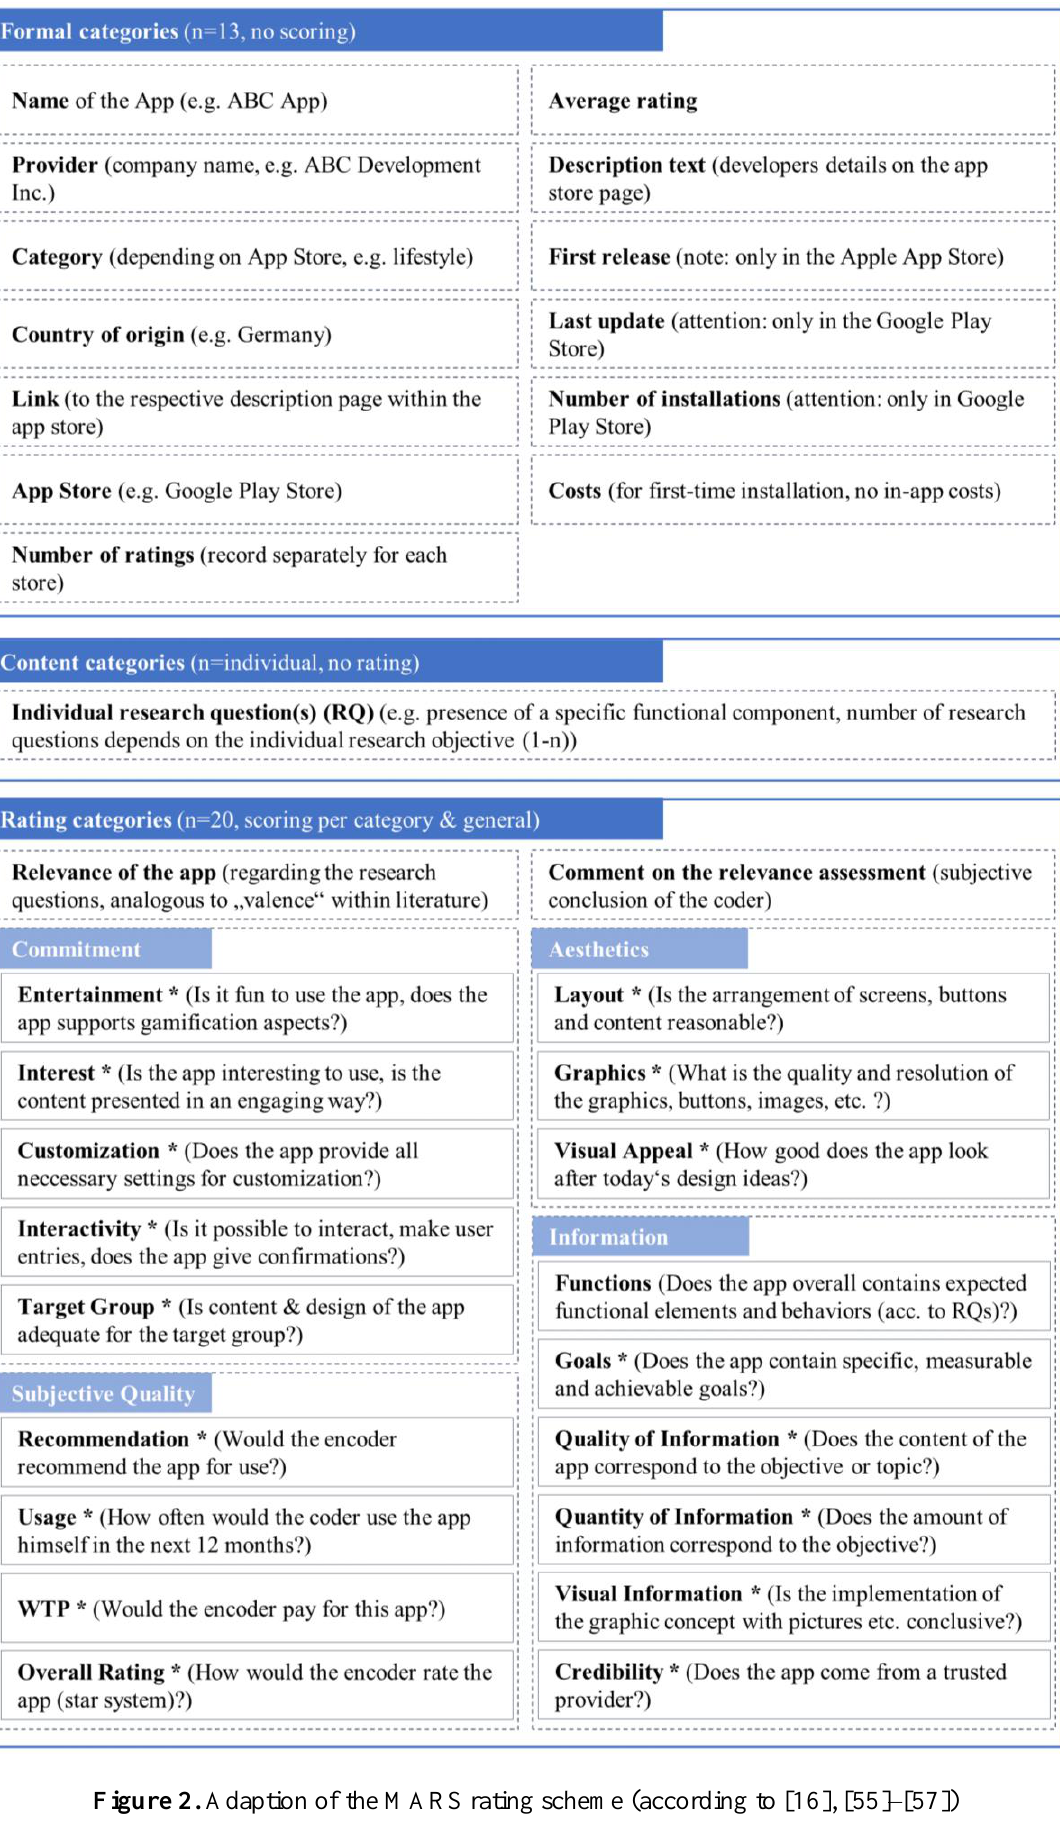
Figure 2. Adaption of the MARS rating scheme (according to [16],